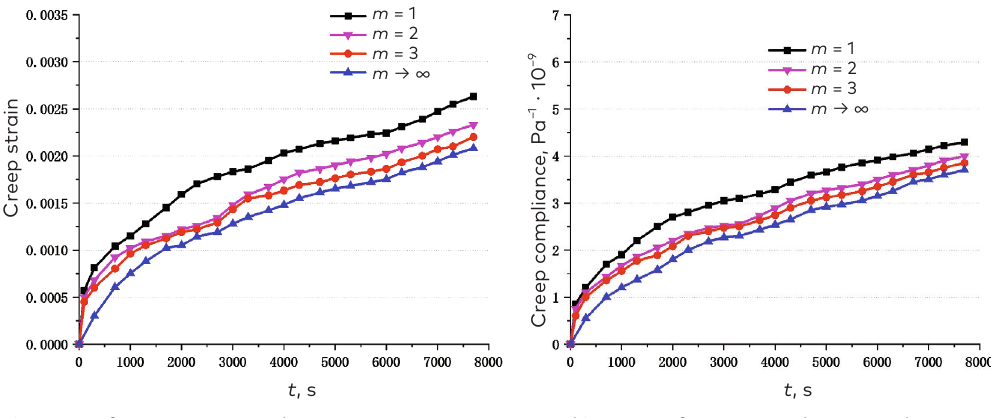
Figure 14. Effects of aggregate heterogeneity on creep behaviours of asphalt